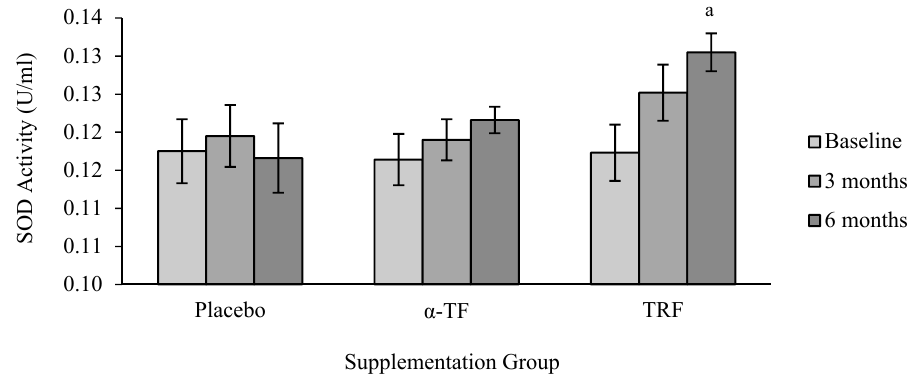
Figure 1. Effect of α -tocopherol ( α -TF) and tocotrienol-rich fraction (TRF) supplementation on superoxide dismutase (SOD) activity for 6 months. a = statistically significant compared to 0-month TRF group, p < 0.05.